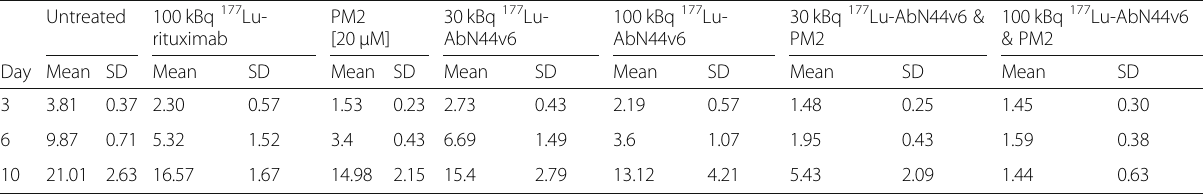
Table 2 UM-SCC-74B spheroid growth ratio-development over time in mean and SD. n ≥ 4